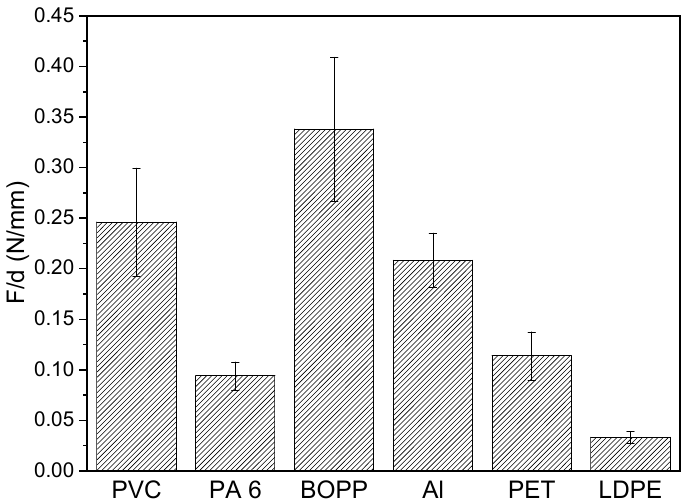
Figure 10. Peel test results for measured surfaces with peel force/width as the studied quantity with standard deviation values (error bars) from three experiments.